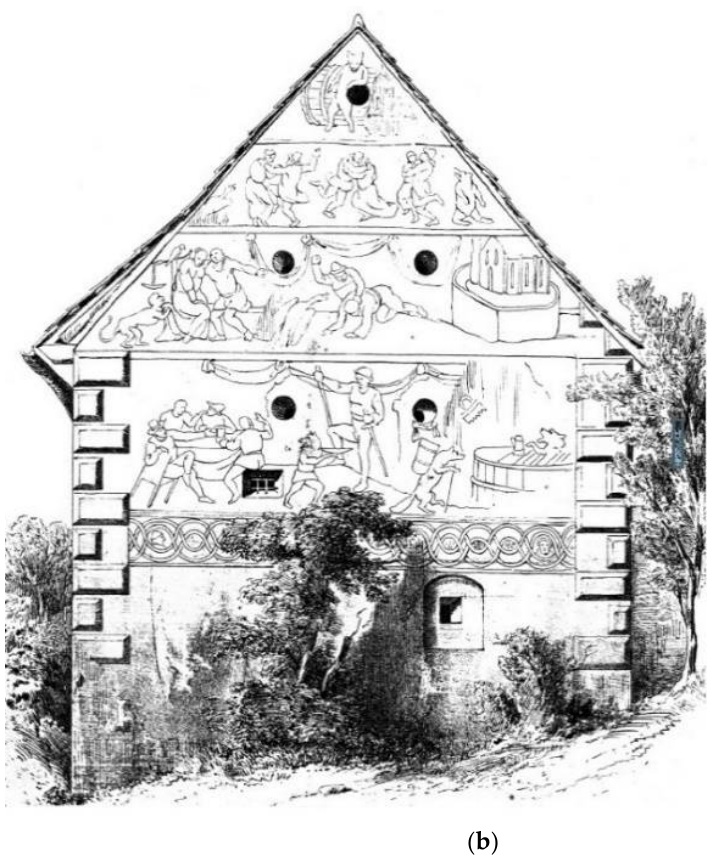
Figure 1. ( a , b ) Sgraffito decoration of the barn at Czocha Castle according to the inventory of M. Lohde 1860s. Source: Lohde (1868, fol. 9).